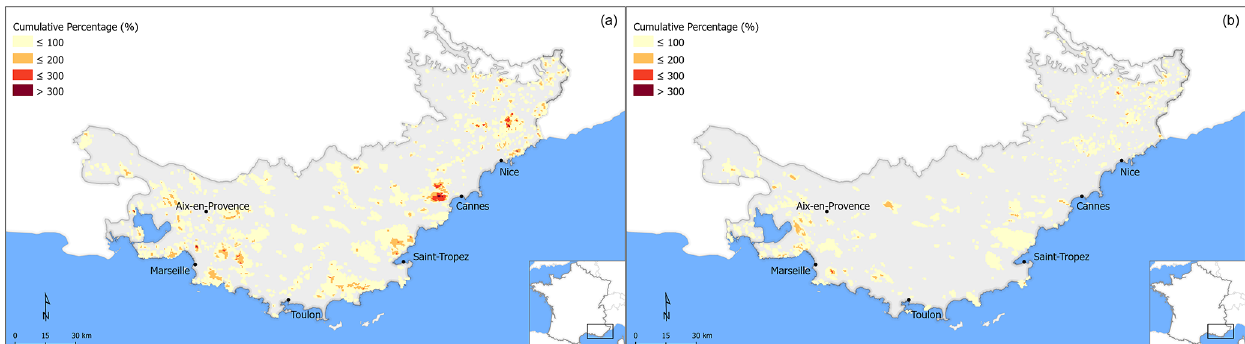
Figure 9. Cumulative percentage of the forested burned areas in the 1970–1994 interval (a) and in the 1995–2019 interval (b) over a 500 × 500m